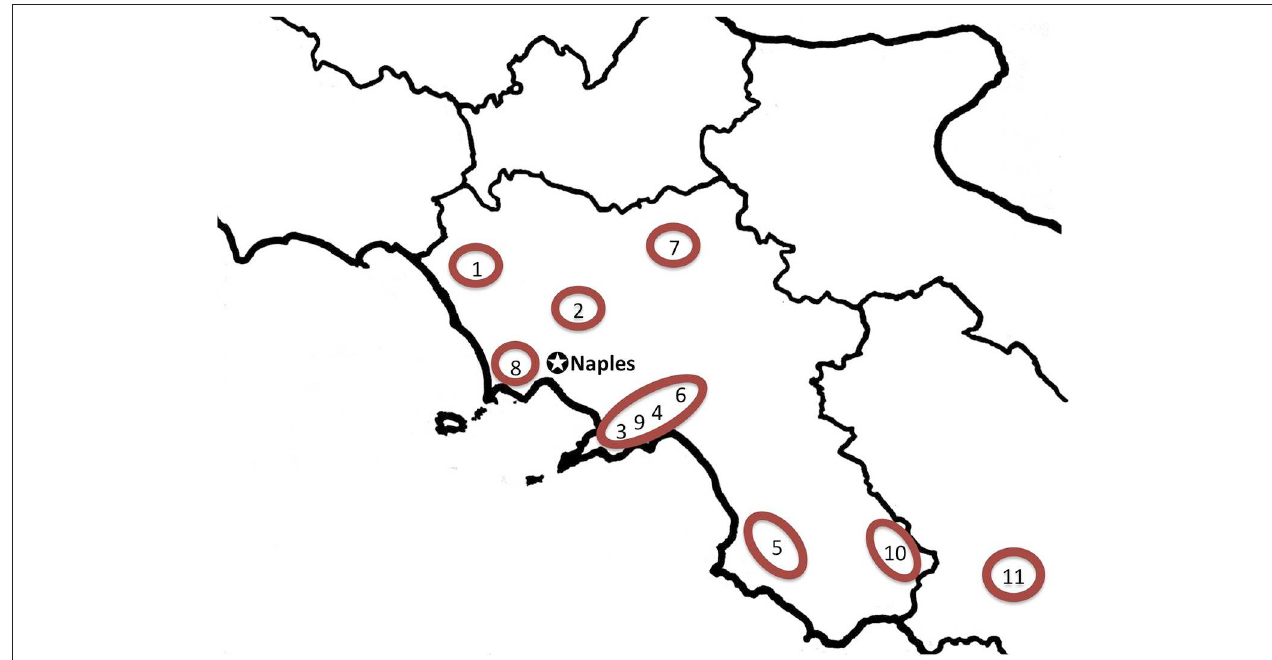
FIGURE 1 | Map of Campania and adjacent regions indicating considered field studies addressing popular medicinal plant use. 1, Roccamonfina, Caserta ( Antonone et al., 1988); 2, Caserta, Caserta (De Feo et al., 1991); 3, Peninsula Sorrentina, Napoli/Salerno (De Feo et al., 1992); 4, Coast of Amalfi, Salerno (De Feo and Senatore, 1993); 5, Monte Vesole and Ascea, Salerno (Scherrer et al., 2005); 6, Montecorvino Rovella, Salerno (De Natale and Pollio, 2007); 7, Sannio area, Benevento ( Guarino et al., 2008); 8, Phlegraean Fields Regional Park (Motti et al., 2009); 9, Amalfi Coast (Savo et al., 2011); 10, National Park of Cilento and Vallo di Diano ( Di Novella et al., 2013); 11, Rotonda, Pollino National Park (Di Sanzo et al., 2013).